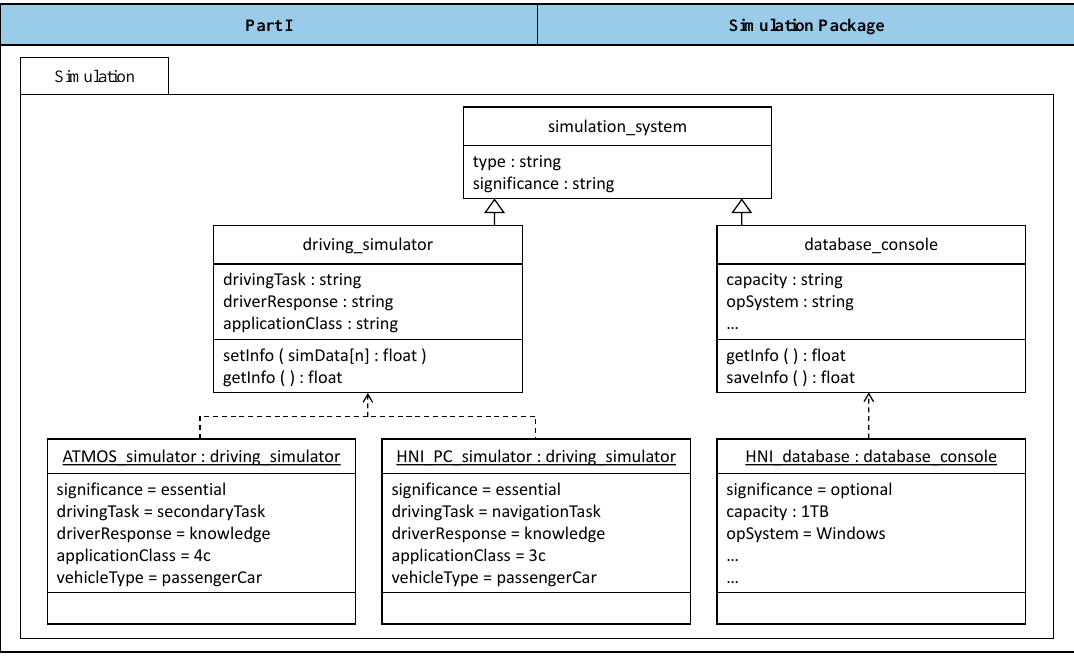
Figure 11. UML (The unified modeling language) class diagram of the selected simulation system components—package 1.